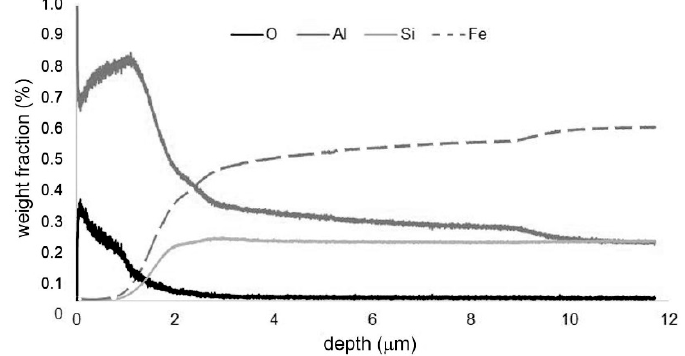
Figure 10. Concentration-depth profile of FeAl20Si20 alloy after cyclic oxidation at 1000 ◦ C for 400